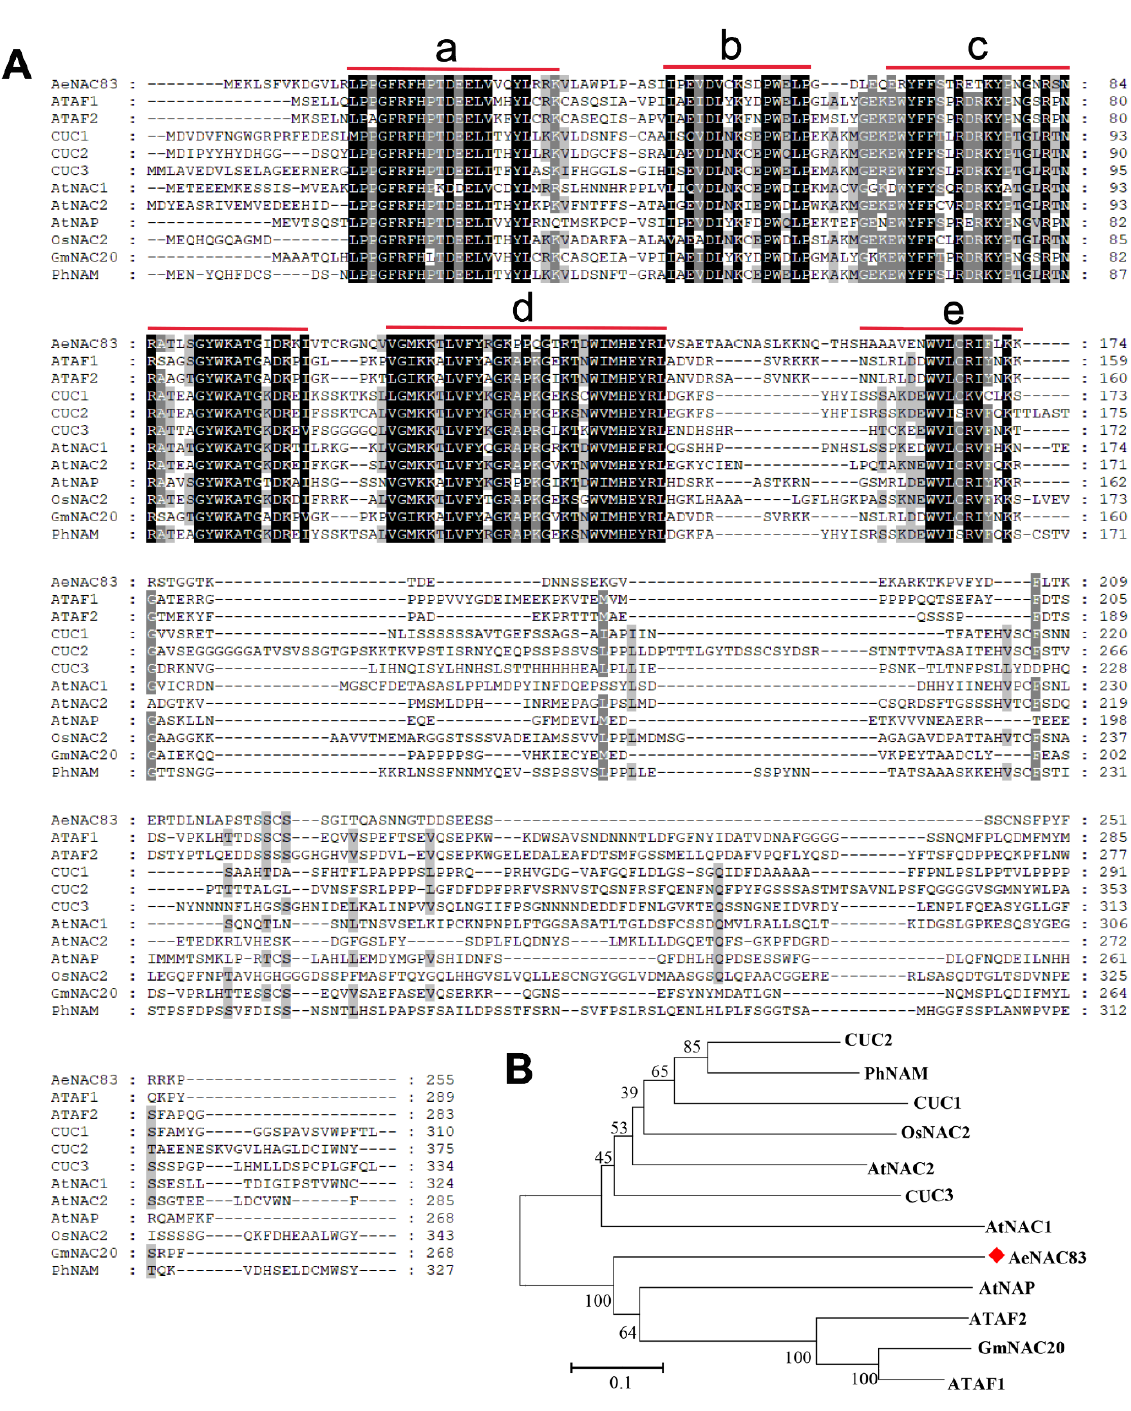
Figure 1. Characterization of AeNAC83: ( A ) Multiple sequence alignment of AeNAC83 and its homologous NAC proteins. The NAC domain with five conserved regions (a–e) are indicated by red lines; ( B ) Phylogenetic analysis of AeNAC83 with its homologous NAC proteins.